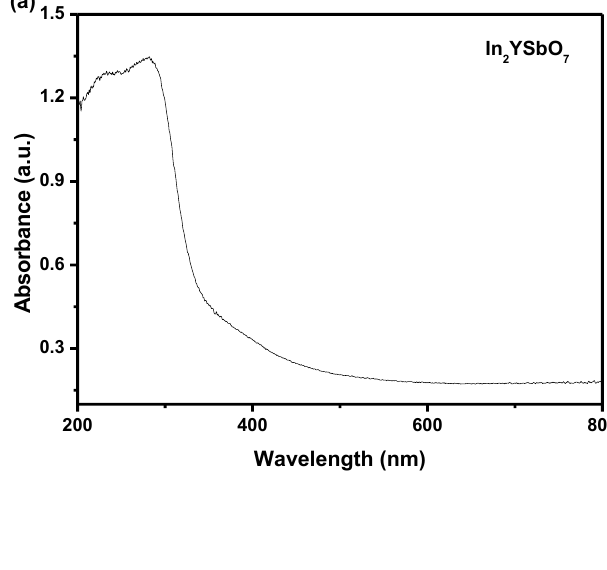
Figure 7. ( a ) The diffused reflection spectrum of BiSnSbO 6 ; ( b ) Correlative diagram of ( αhν ) 1/2 and hν for BiSnSbO 6 . Figure 8a,b shows the U – V DRS of IBHP. According to the above methods, the value of Eg for IBHP was estimated to be 2.73 eV. The reckoning value of n was about 0.5; as a result, the optical transition of IBHP was a direct transition.